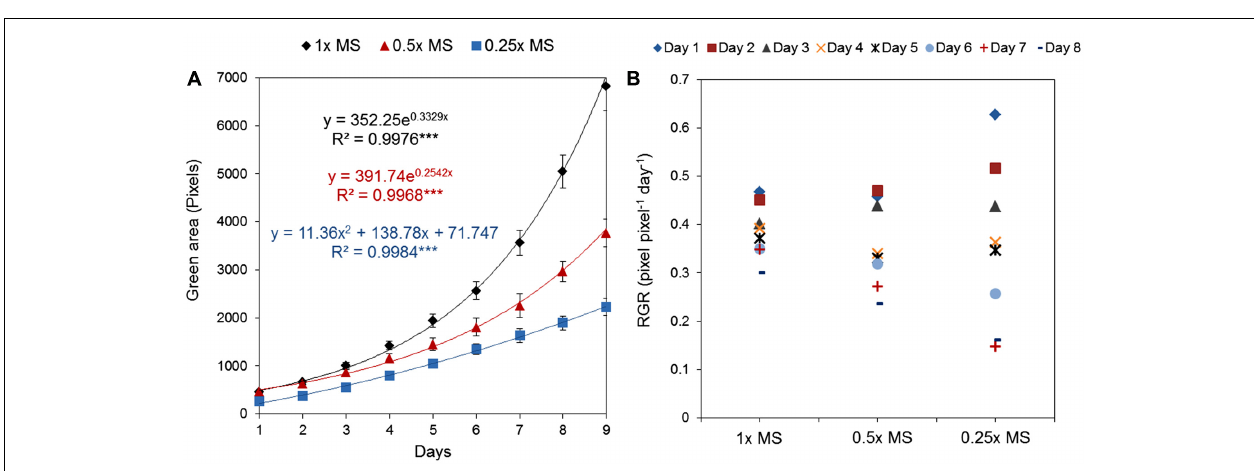
0.25 × , 0.5 × , and 1 × . A clear concentration-dependent increase in rosette area was found, indicating that 1 × MS is the best growing medium for Arabidopsis seedlings in vitro ( Figure 8A